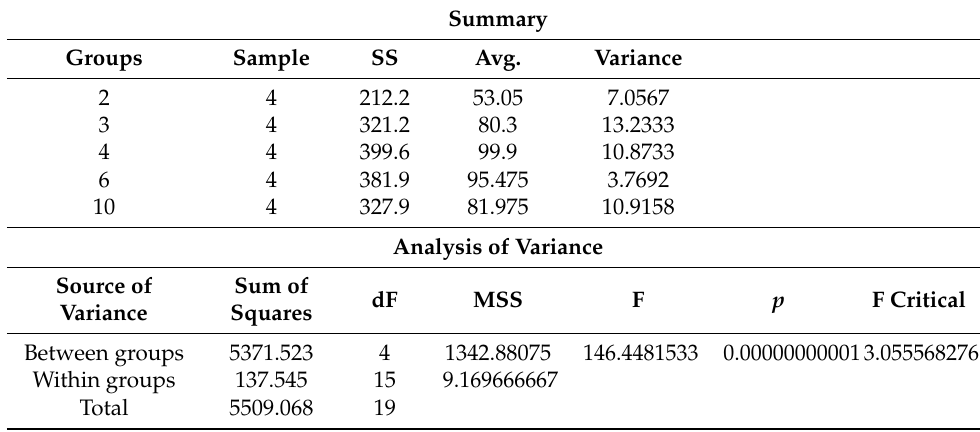
Table 2. One-way analysis of variance for CA production